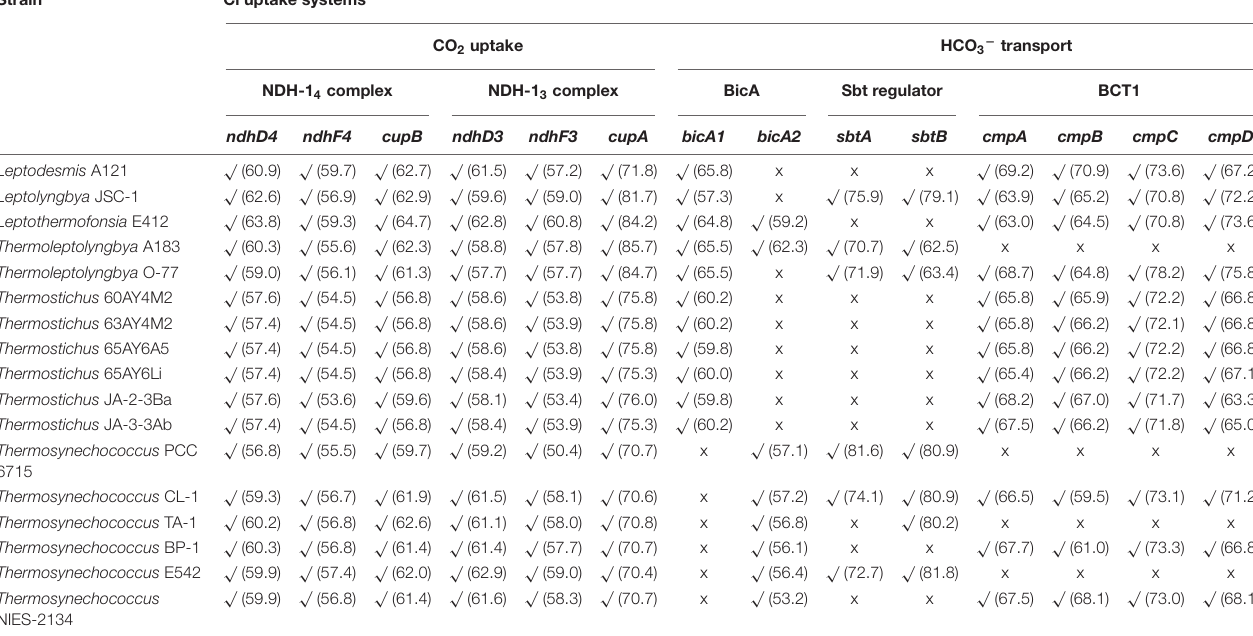
TABLE 2 | Availability of genes encoding Ci uptake systems of thermophilic cyanobacteria studied.